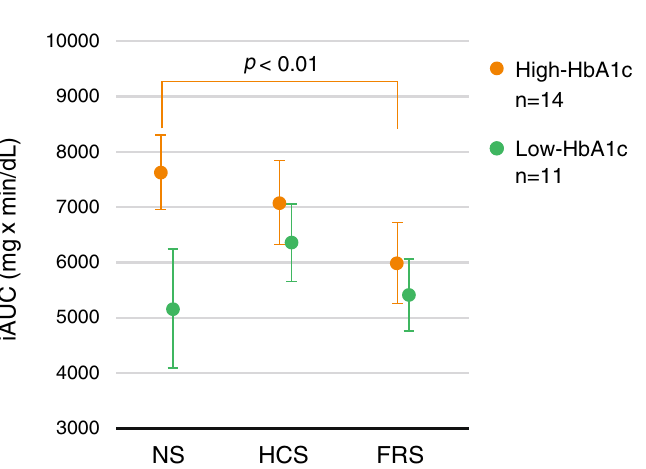
Figure 4. Incremental area under the curve (iAUC) for the three sound conditions for the participants grouped by the value of HbA1c. Orange indicates the mean and the standard error of mean of 14 participants in the high-HbA1c group and green indicates those of 11 participants in the low-HbA1c group. Mean HbA1c of high-HbA1c and low-HbA1c groups was 5.80% (5.5–6.5%) and 5.17% (4.5–5.4%), respectively. iAUC was significantly smaller in the full-range sound condition than in the no sound in the high-HbA1c group, whereas this tendency was not observed in the low-HbA1c